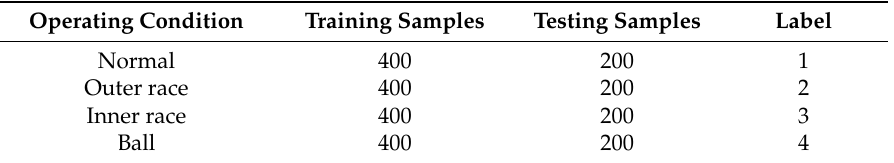
Table 3. The details of each state of rolling element bearing